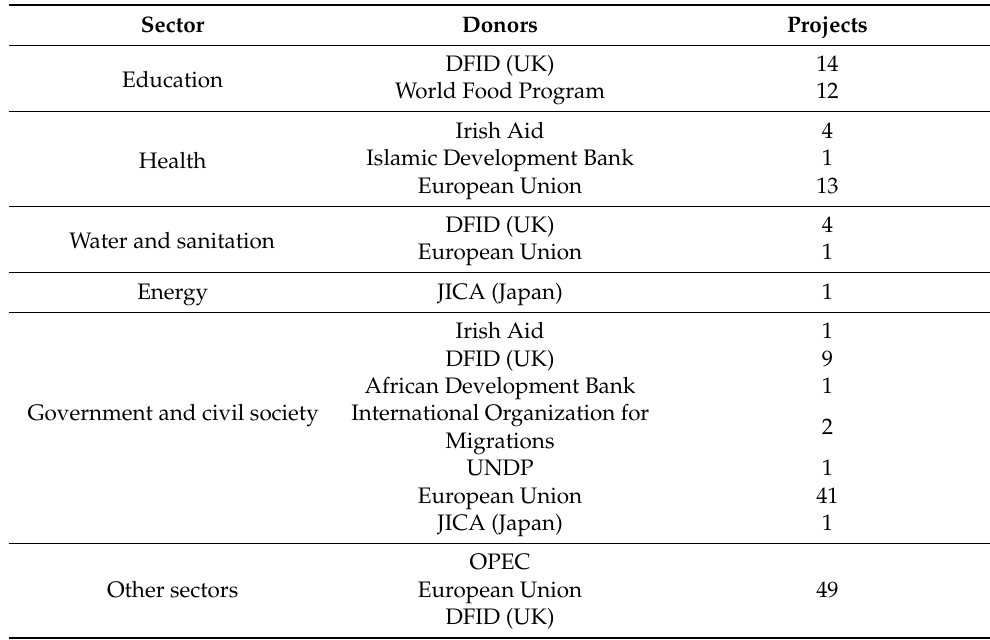
Table 8. Sectors, donors and projects for Sierra Leone collected by